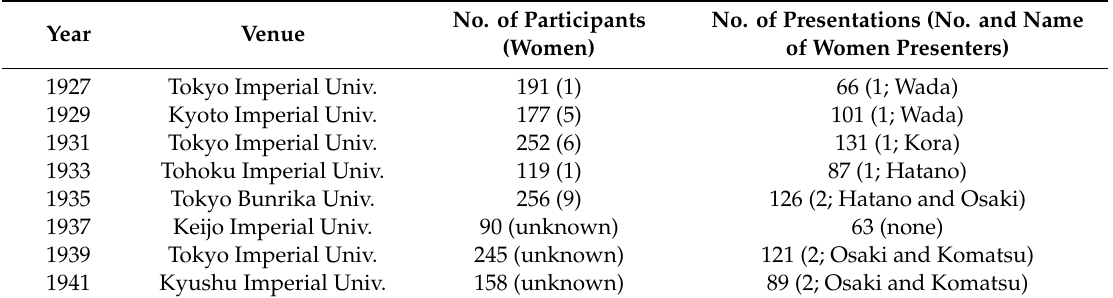
Table 1. JPA meetings before